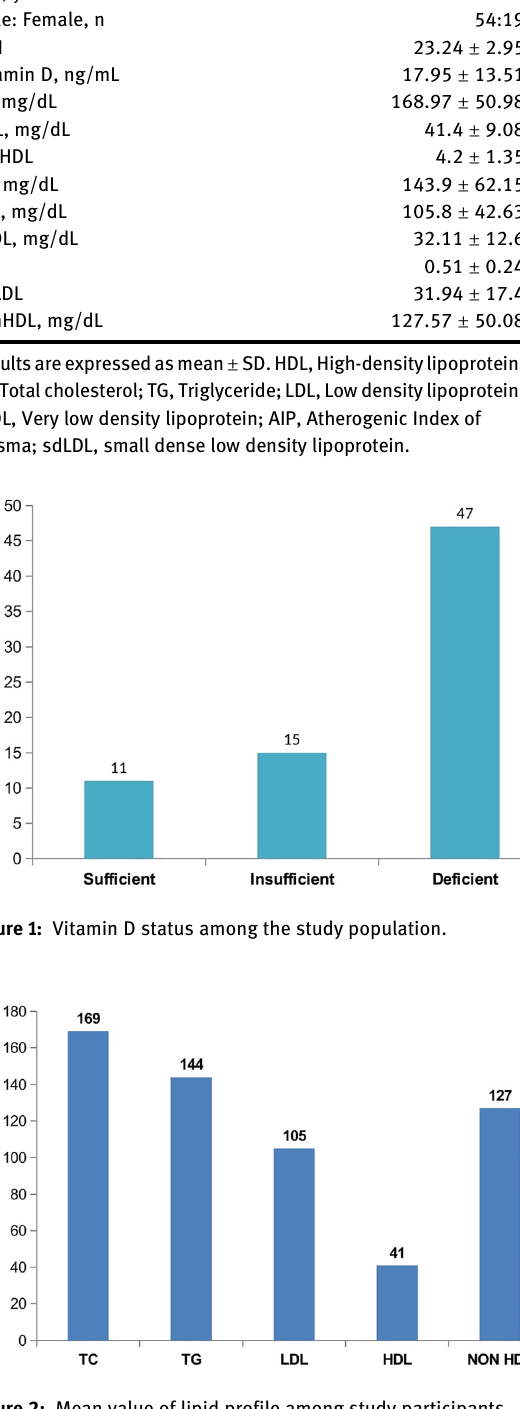
Figure 2: Mean value of lipid profile among study participants. TC, Total cholesterol; TG, Triglyceride; LDL, Low density lipoprotein; HDL, High-density lipoprotein.